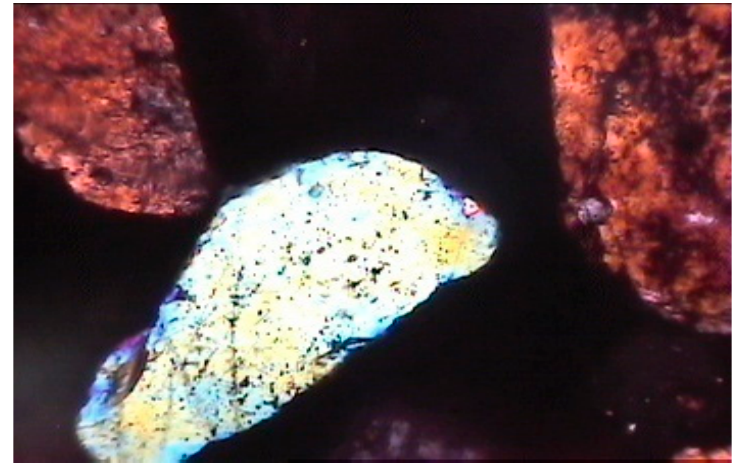
Figure 12. Photomicrograph of mix nano-sized wet-ground cement and fine aggregates showing dense cement phase and good contact between cement paste and aggregate grains (magnification of 60× under polarized light).